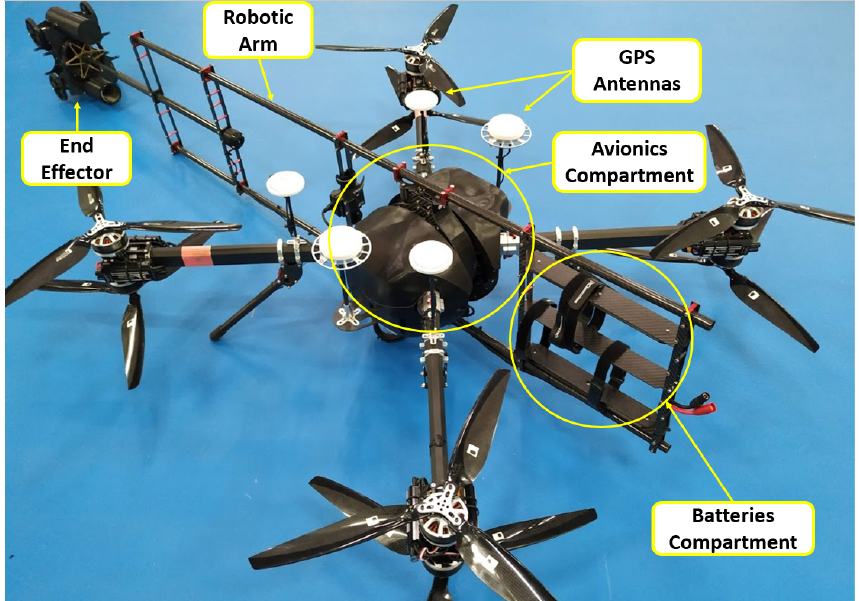
Figure 5. AeroX robot for contact